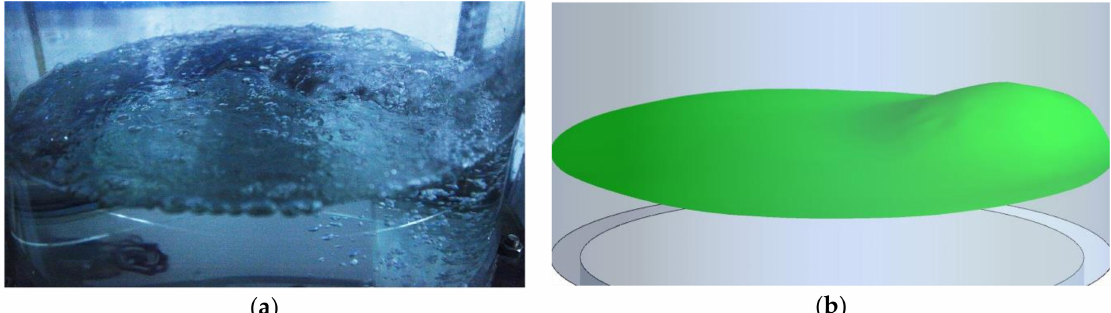
Figure 5. Fluctuation on the free surface ( a ) experimental and ( b ) simulation.